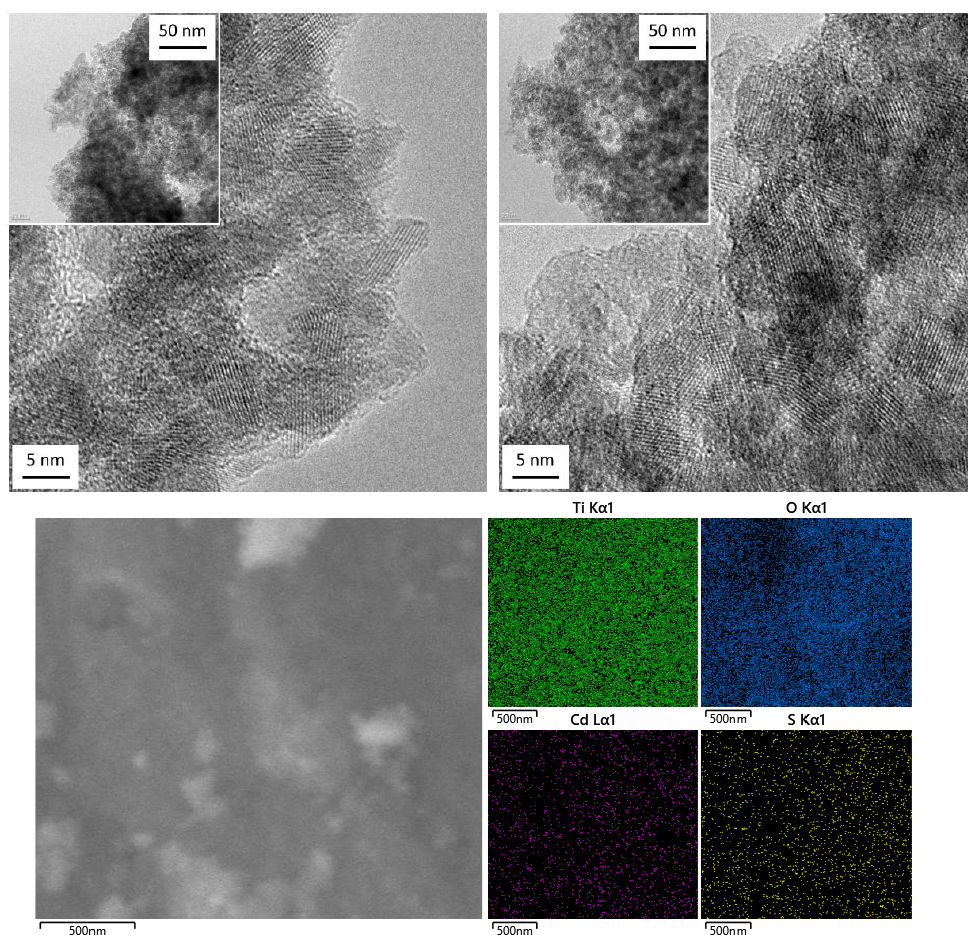
Figure 2. Upper section: HRTEM images of CdS/TiO 2 -1 ( left ) and CdS/TiO 2 -2 ( right ) at low and high magnification. Lower section: FESEM secondary electron images and corresponding Ti, O, Cd and S EDS maps.